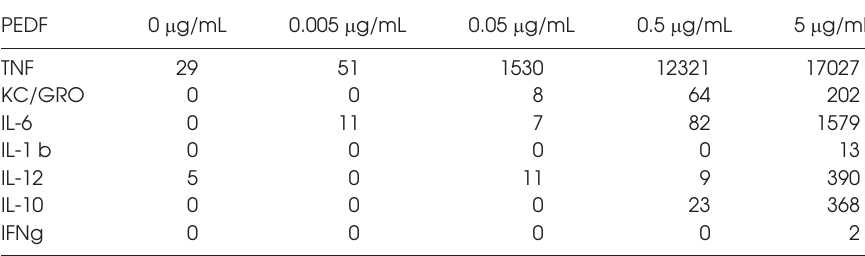
Table 1. PEDF-induced cytokine release at 6 h (pg/mL). PEDF